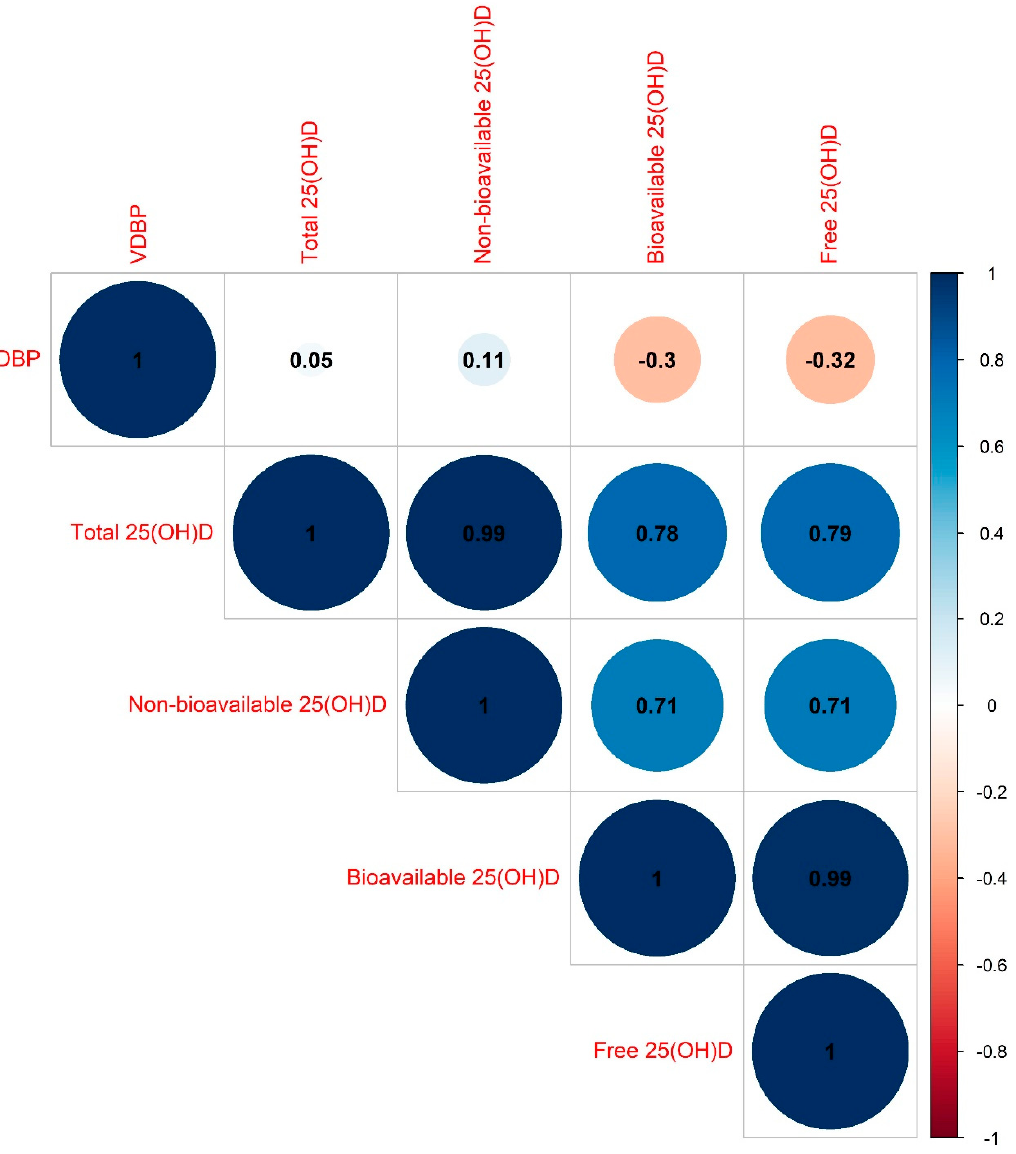
Figure 2. Correlation matrix between VDBP, total, non-bioavailable, bioavailable, and free 25(OH)D concentrations. Abbreviations: VDBP: vitamin D binding protein.